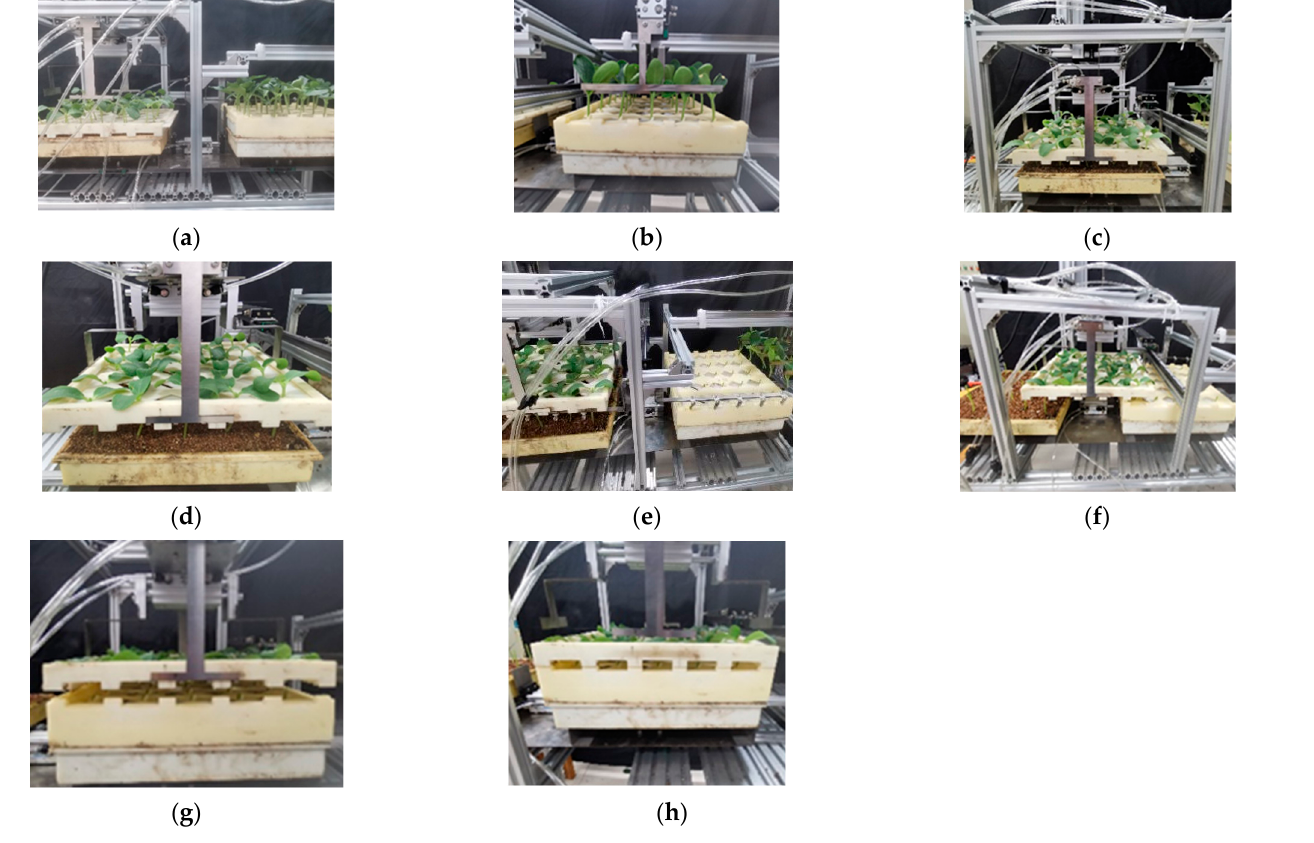
Figure 14. Grafting process of the full-tray grafting prototype. ( a ) Tray positioning; ( b ) Clamping the upper part of the rootstock; ( c ) Scion-positioning device lift; ( d ) Scion positioning; ( e ) Cutting; ( f ) Rootstock transfer; ( g ) Rootstock and scion docking; ( h ) Docking completed.